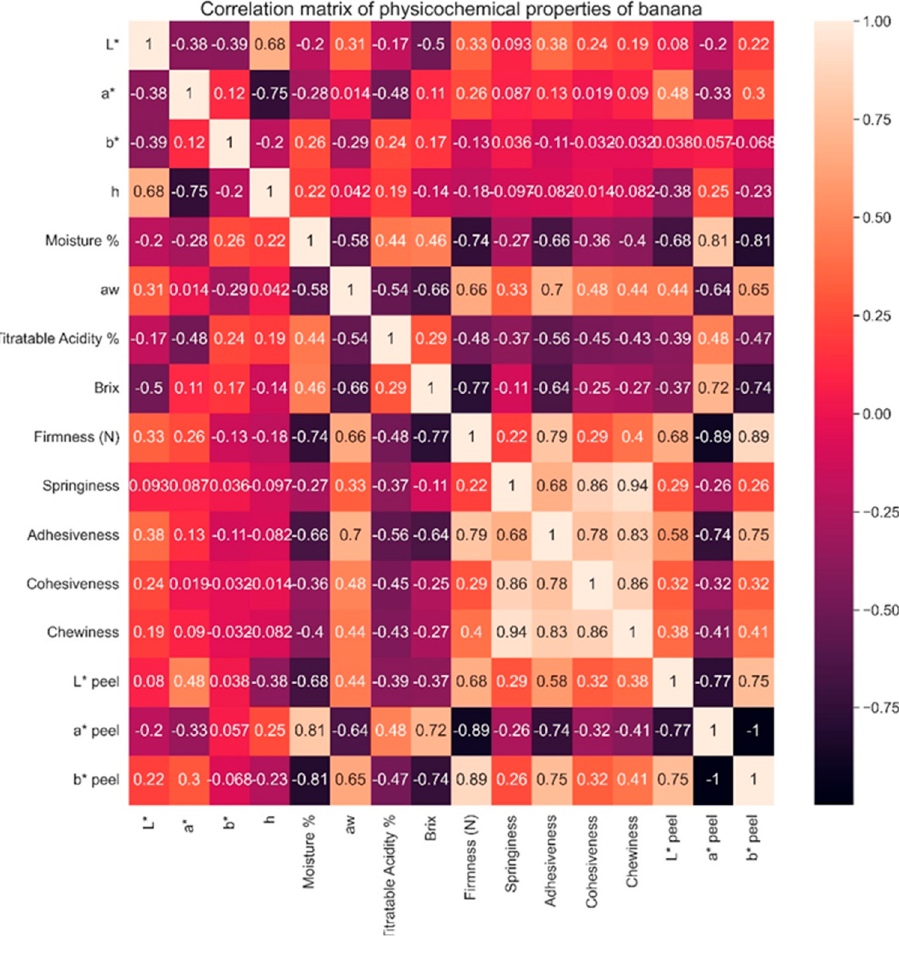
Figure 8. Pairwise correlation matrix between physicochemical parameters of the banana flesh and the features L*, a*, b* of the banana peel, during storage.